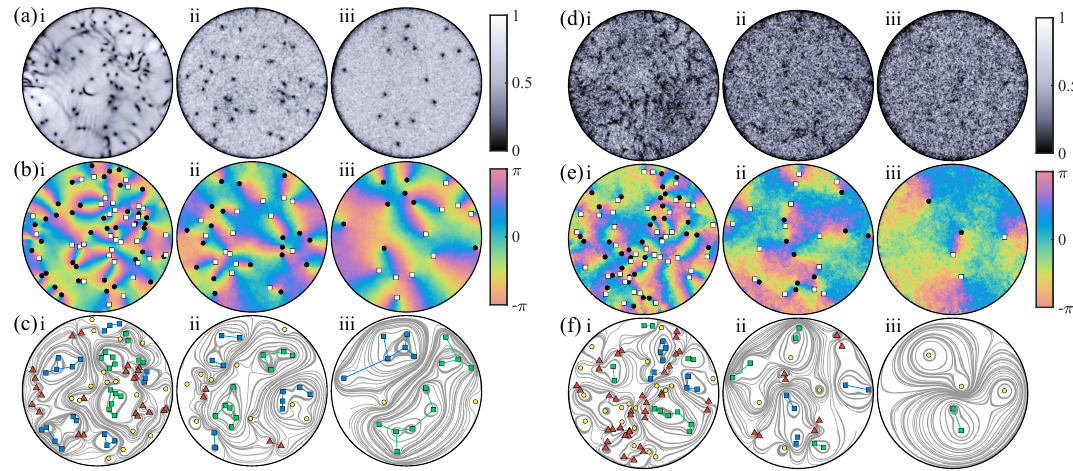
Figure 1: Temporal evolution of the classical field ψ ( r ) for two condensate fractions, = 1 [ (a)–(c) ] and n ≈ 0.75 [ (d)–(f) ] , with frames i, ii and iii in each row n 0 0 ≈ 10, t / t ≈ 900 and t / t ≈ 4500, respectively. For corresponding to times t / t o o o each case the classical field density | ψ ( r ) | 2 is shown in rows (a) and (d), the phase in (b) and (e), and the classified vortices and incompressible velocity field streamlines in (c) and (f). In (b) and (e), vortices (antivortices) are indicated with black dots (white squares), while in (c) and (f), clusters of vortices (antivortices) are identified as blue (green) squares, dipoles as red triangles, and free vortices as yellow circles. − 4 ξ − 2 In rows (a) and (d), the density is normalised to its maximum value, 1.7 × 10 o − 4 ξ − 2 and 3.0 × 10 , o